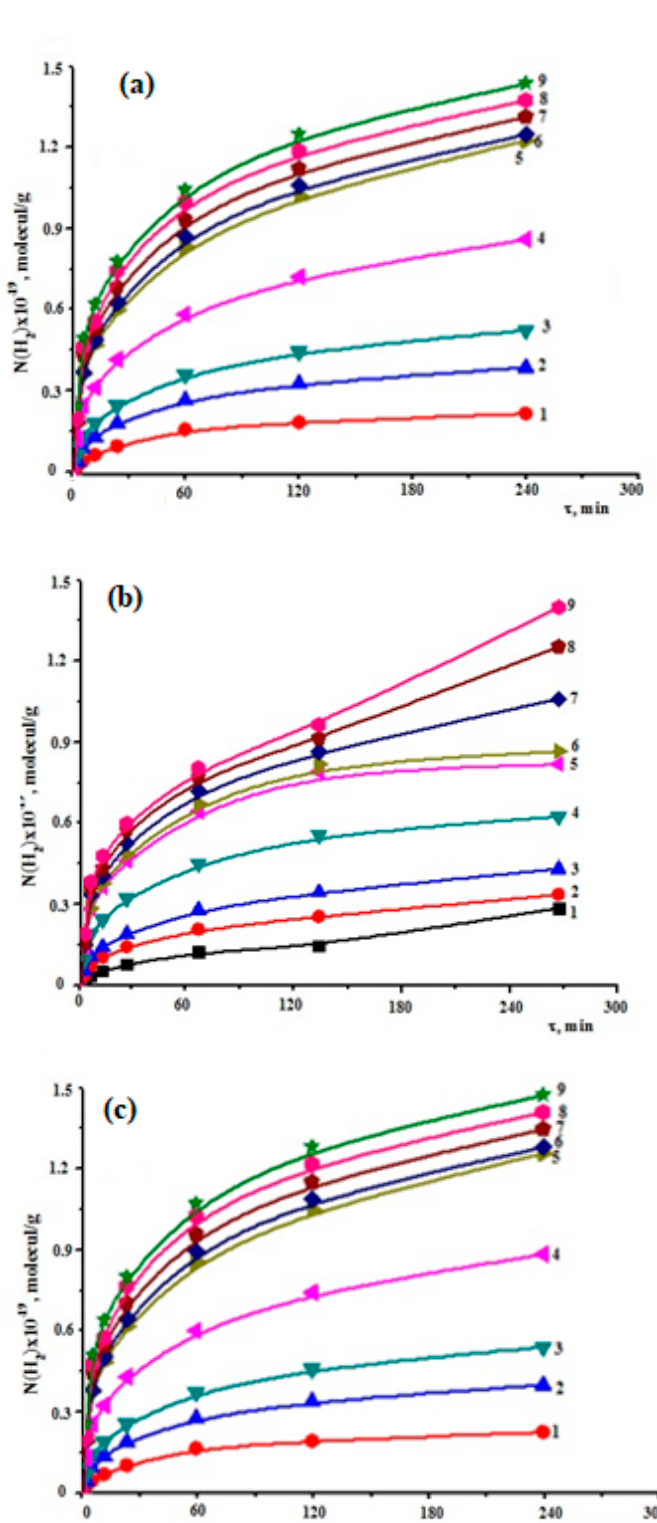
Figure 3. Kinetics of accumulation of molecular hydrogen during ( a ) thermal, ( b ) radiation, and ( c ) radiation–thermal decomposition of seawater on the surface of Zr1%Nb alloys at different tem- peratures: 1: 473 K; 2: 573 K; 3: 673 K; 4: 773 K; 5: 873 K; 6: 973 K; 7: 1073 K; 8: 1173 K; and 9: 1273